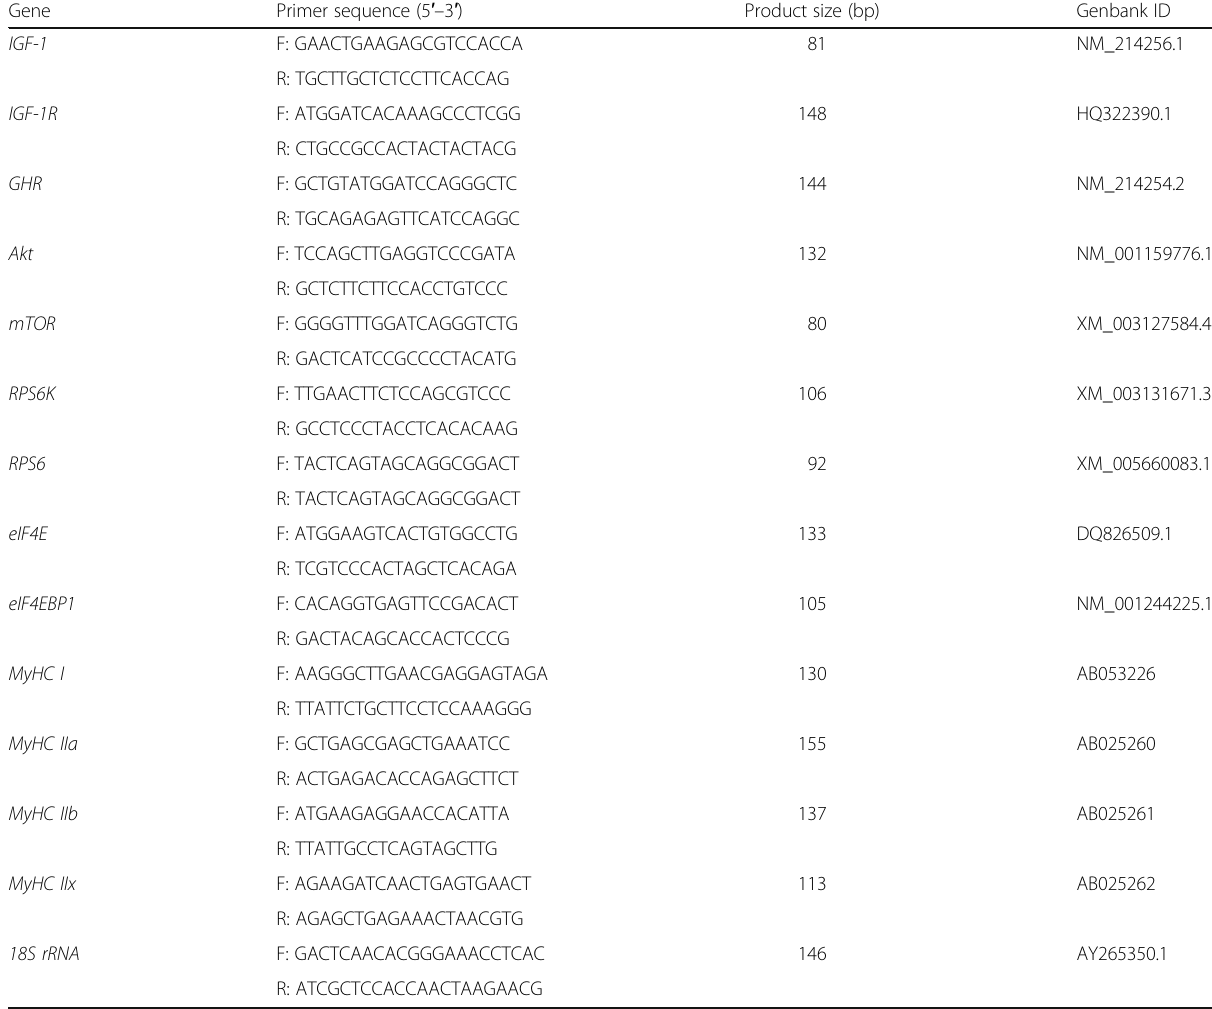
Table 1 Primer sequences of target and reference genes Gene Primer sequence (5 ′– 3 ′ ) Product size (bp) Genbank